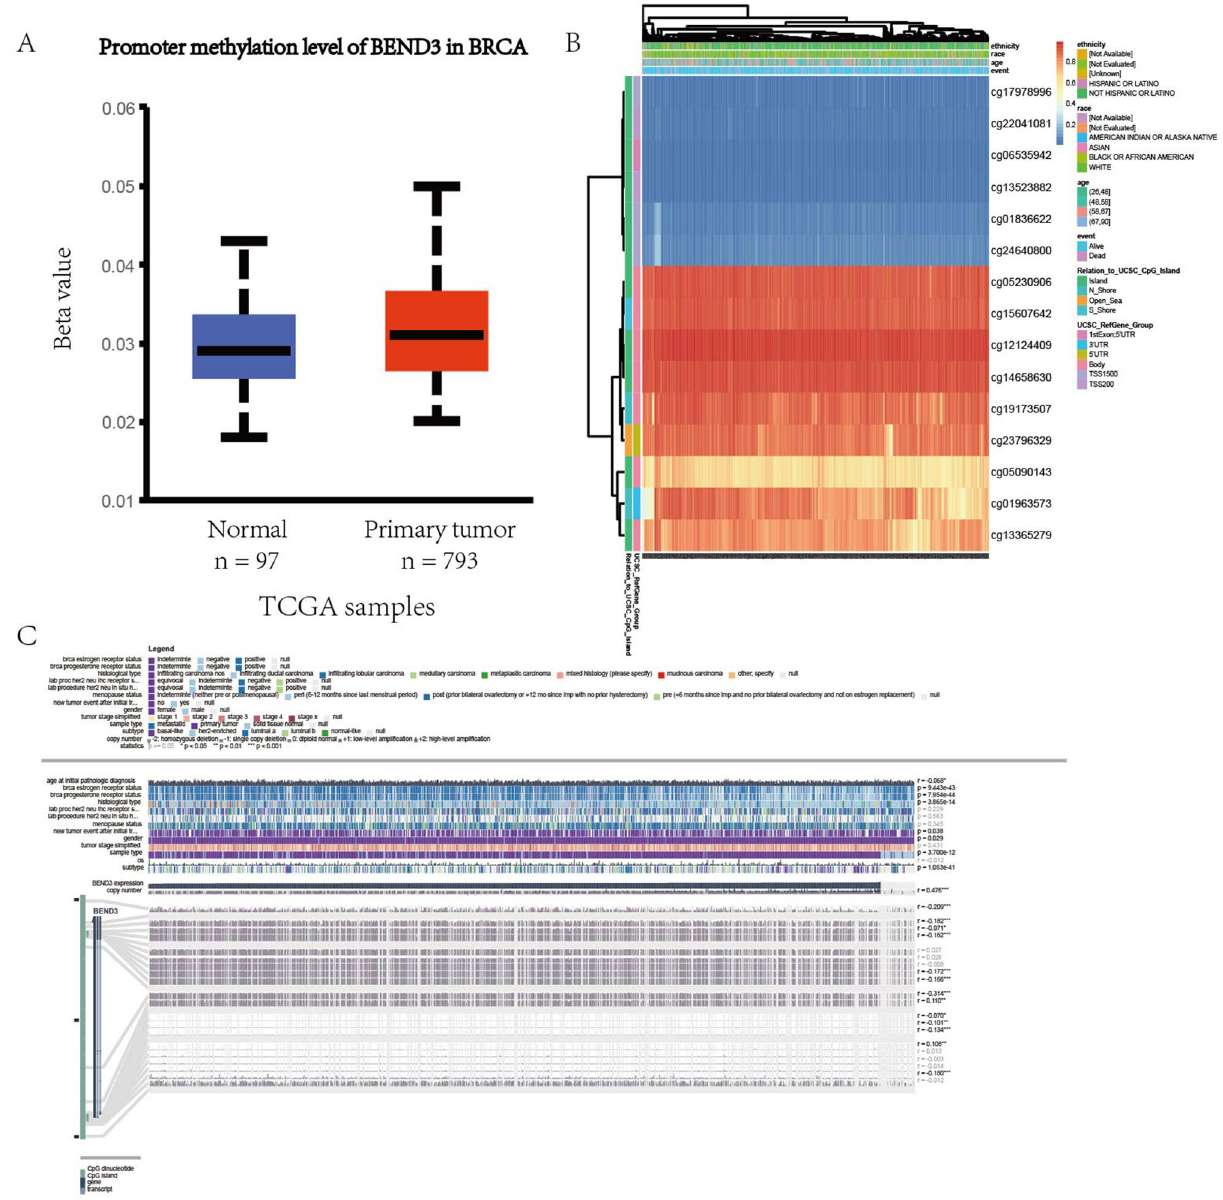
Figure 15. Analysis of BEND3 and methylation. ( A ) The promoter methylation level of BEND3 in BRCA. ( B ) The correlations between methylation sites of BEND3 and clinical features in BRCA. ( C ) The methylation information of CpG islands of